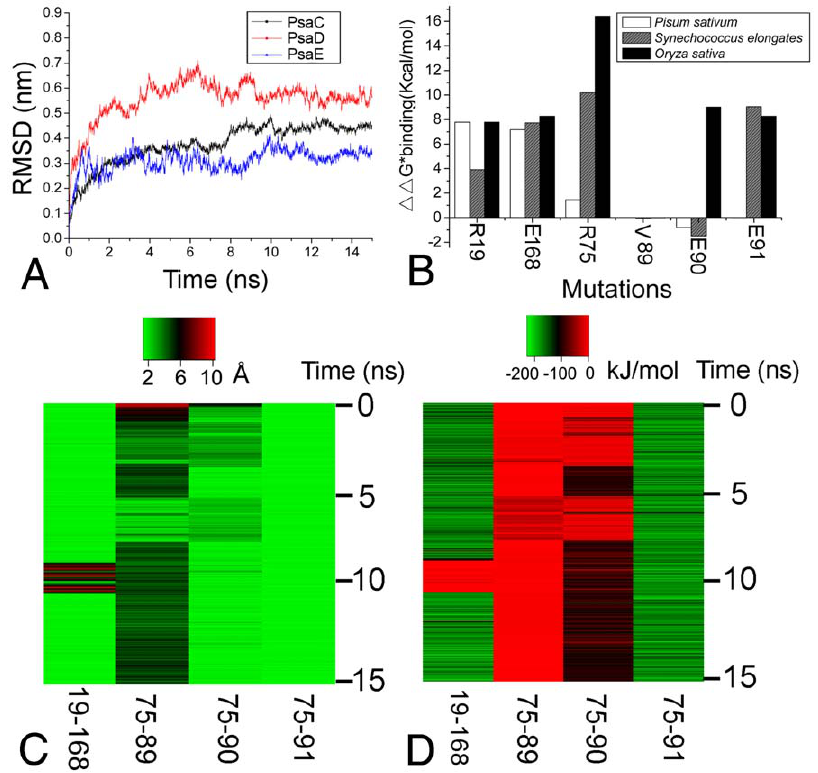
Figure 6. Characterization of stromal ridge complex in explicit solvent MD. A: The RMSD of the PsaC, PsaD and PsaE for the 15 ns MD run. B: Computational alanine scanning mutagenesis results for six single mutations from Oryza sativa , Synechococcus elongates and Pisum sativum. C: The closest atom distance in the residue pairs R19-E168, R75-V89, R75-E90, R75-E91. D: Interaction energy in the residue pairs R19-E168, R75-V89, R75-E90, R75-E91.